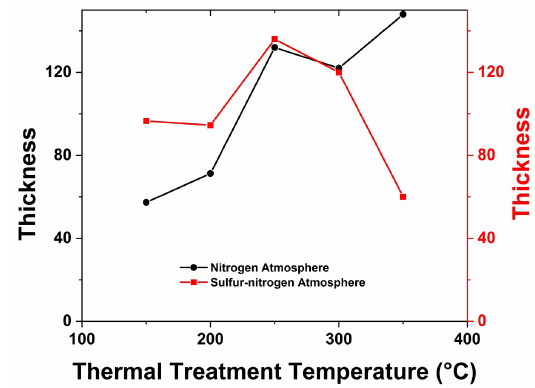
S grown by PVD with 2 3